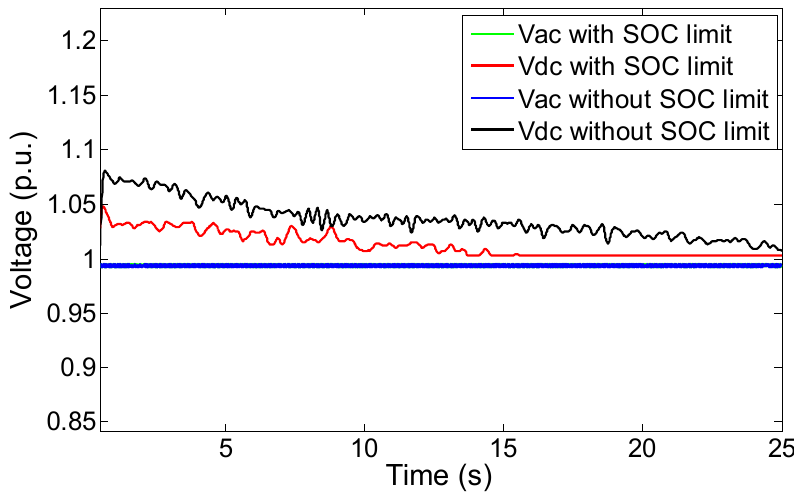
Figure 24. AC and DC voltages in the second case.